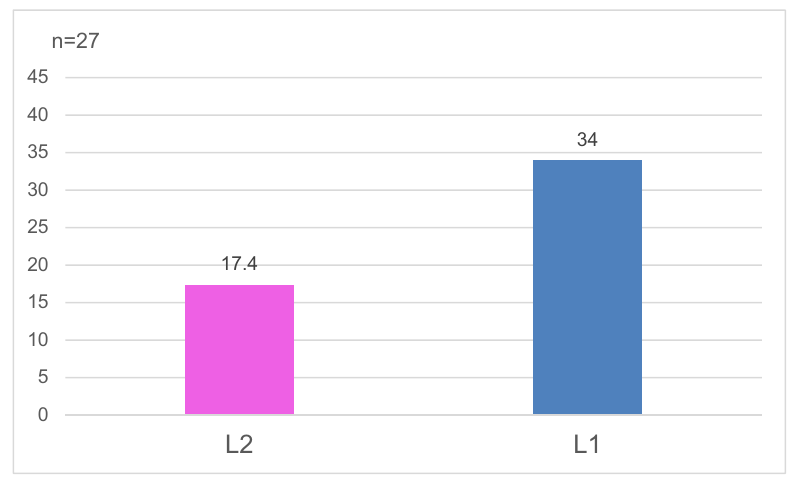
Figure 1: Self - perceptions of L2 English and L1 Japanese abilities ( Likert points ) .